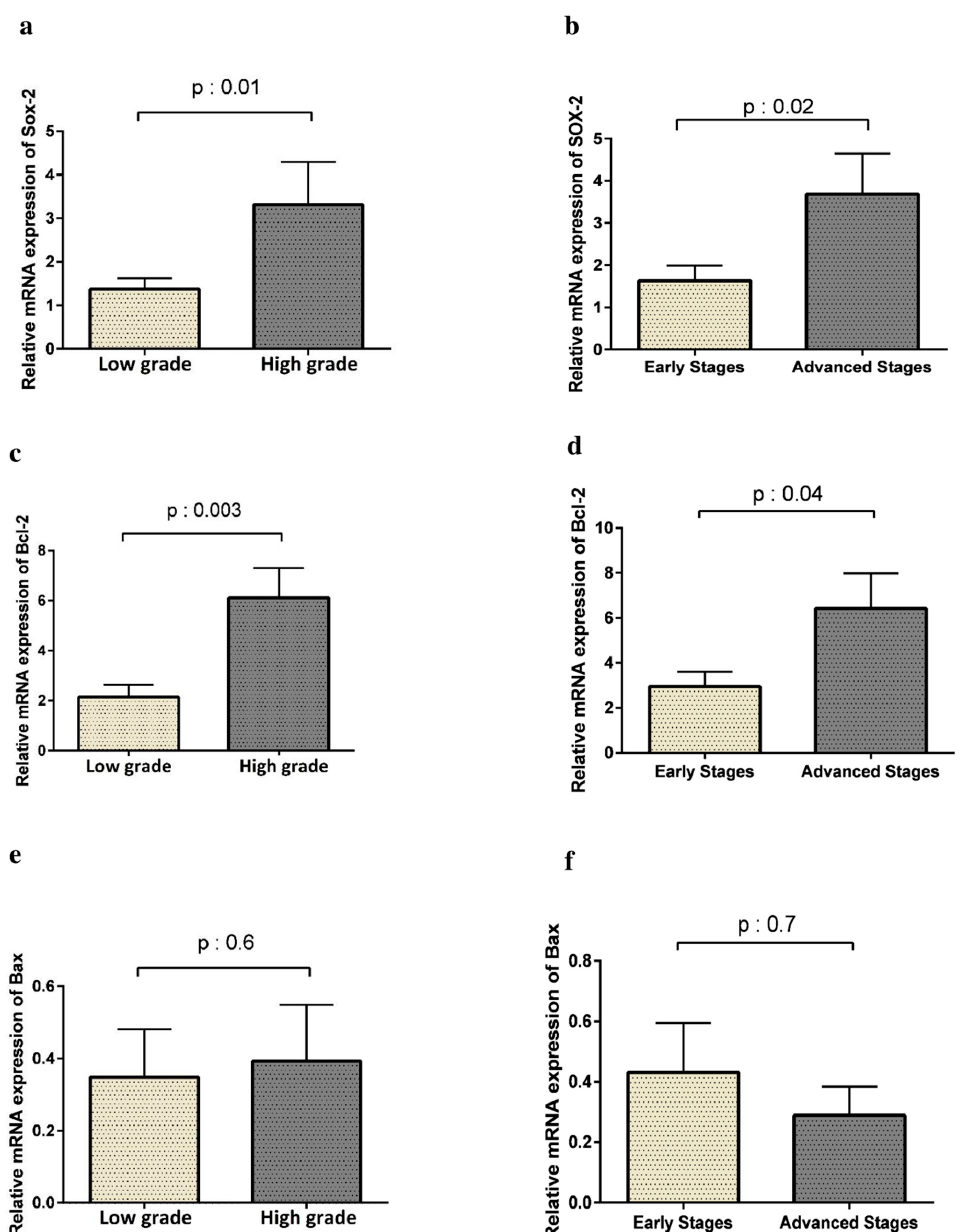
Figure 3. Based on the Edmondson grading system, 71.6% ( n = 38) of tumor samples were low grade and 28.3% ( n = 15) were high grade. Moreover, based on the TNM staging system of the AJCC/UICC, 68.75% ( n = 33) of patients were in the early stage and 31.25% ( n = 15) were in the advanced stage of HCC. mRNA expression of both SOX2 and Bcl2 were higher in high-grade tumors than in low-grade ones ( a , c ) and also higher in tumors with advanced stages than those with early stages ( b , d ). There was not a significant difference in Bax expression between tumors with different grades or stages ( e , f ). Subsequently, to evaluate the relationship between SOX2 expression and overall sur- vival, HCC patients undergoing sorafenib treatment were divided into two groups based